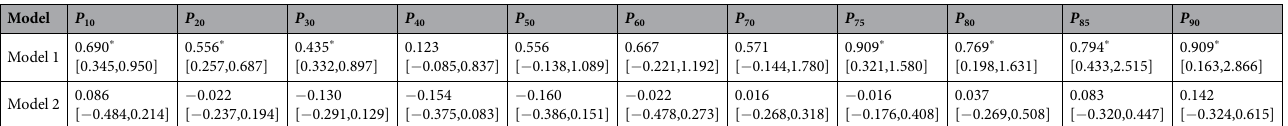
Table 6. Quantile regression coefficients [95% CI ] between FBG and DBP in females. * P < 0.05. CI : confidence interval. Model 1, without adjustments for the confounding factors. Model 2, adjusted for age, BMI, WC, smoking status, alcohol consumption and